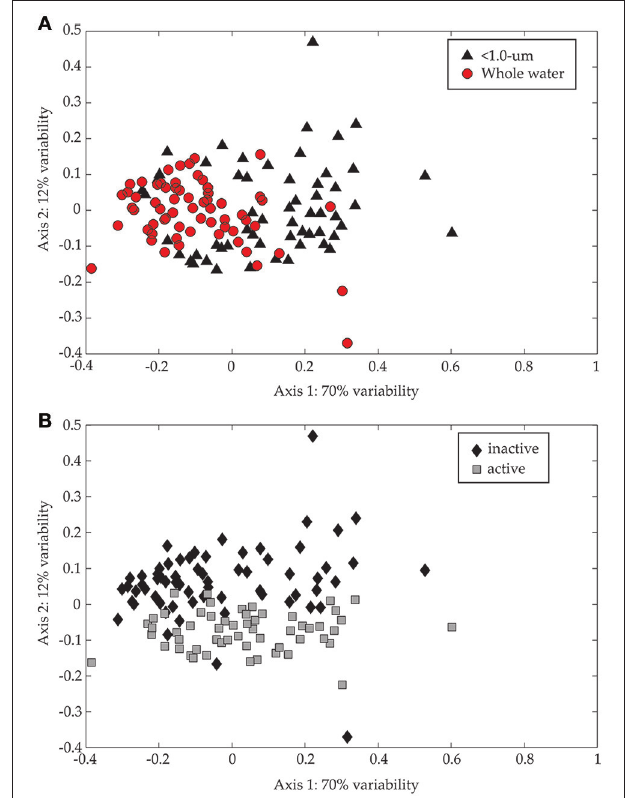
FIGURE 8 | NMS ordination of 16S rDNA CsCl TRFLP samples ( Hin 6I). The same data is presented in both panels. In (A) , the < 1.0- µ m (black triangles) and the whole water (red circles) incubations are presented, while in (B) , the 13 C-enriched (“active”; gray squares) and the non-enriched (“inactive”; black diamonds) regions of the CsCl gradient are presented. The stress for this ordination is 0.169 and the r 2 between the original distance matrix and this NMS ordination is 0.86. The degree of variability represented by each axis was calculated using a Mantel test (see text) and is shown in the axis